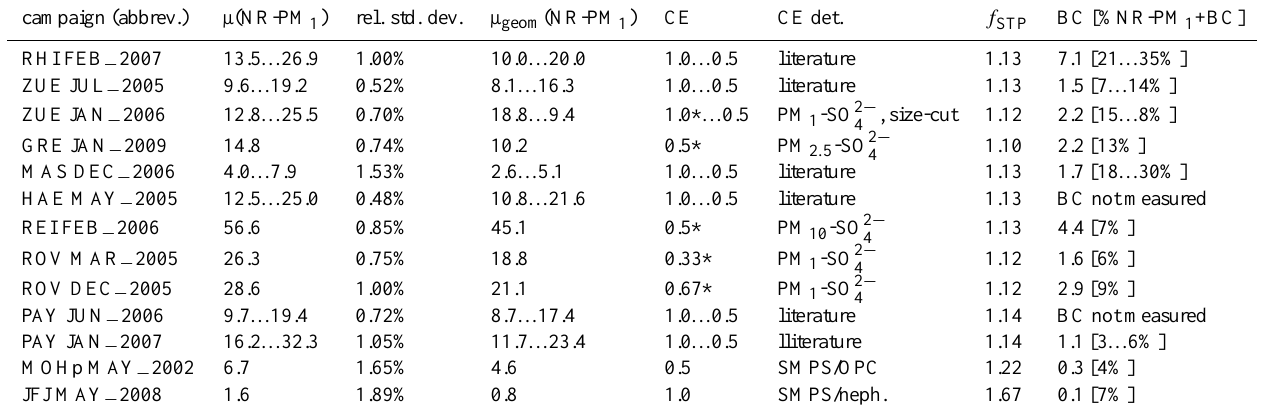
Table 2. Average ambient concentrations (arithmetic mean, µ, and geometric mean, µ geom , in [µgm − 3 ]) for the non-refractory aerosol as measured by the AMS instruments (NR-PM 1 ) for all campaigns (abbreviations see Table 1). The geometric mean was calculated by omitting non-positive values and the standard deviation of this mean was typically about 1µgm − 3 . The standard deviation of the arithmetic mean is 0.5%–2% of the total concentrations given by µ(NR-PM 1 ). Larger uncertainties are associated with the choice of the collection efficiency (CE) of the AMS instrument. It is indicated below how the CE was determined: type of ancillary measurements involved or typical range derived from the literature (see Sect. 2.3.1). Conversion factors to STP, f STP , were calculated as the ratio f STP =( p ◦ T )/( pT ◦ ), where standard temperature, T ◦ =273.15K, and pressure, p ◦ =101325Pa. Averages for black carbon, BC (or elemental carbon, EC), are given in [µgm − 3 ] and their relative fractions in [%] of NR-PM 1 +BC were calculated as BC/(NR-PM 1 +BC). (*=CE determined from sulfate filter measurements: these comparisons, AMS-sulfate vs. IC-sulfate, are based on typically n =4 samples and CE associated uncertainties up to 3 · std =0.18 were calculated in orthogonal distance regressions through the origin.) campaign